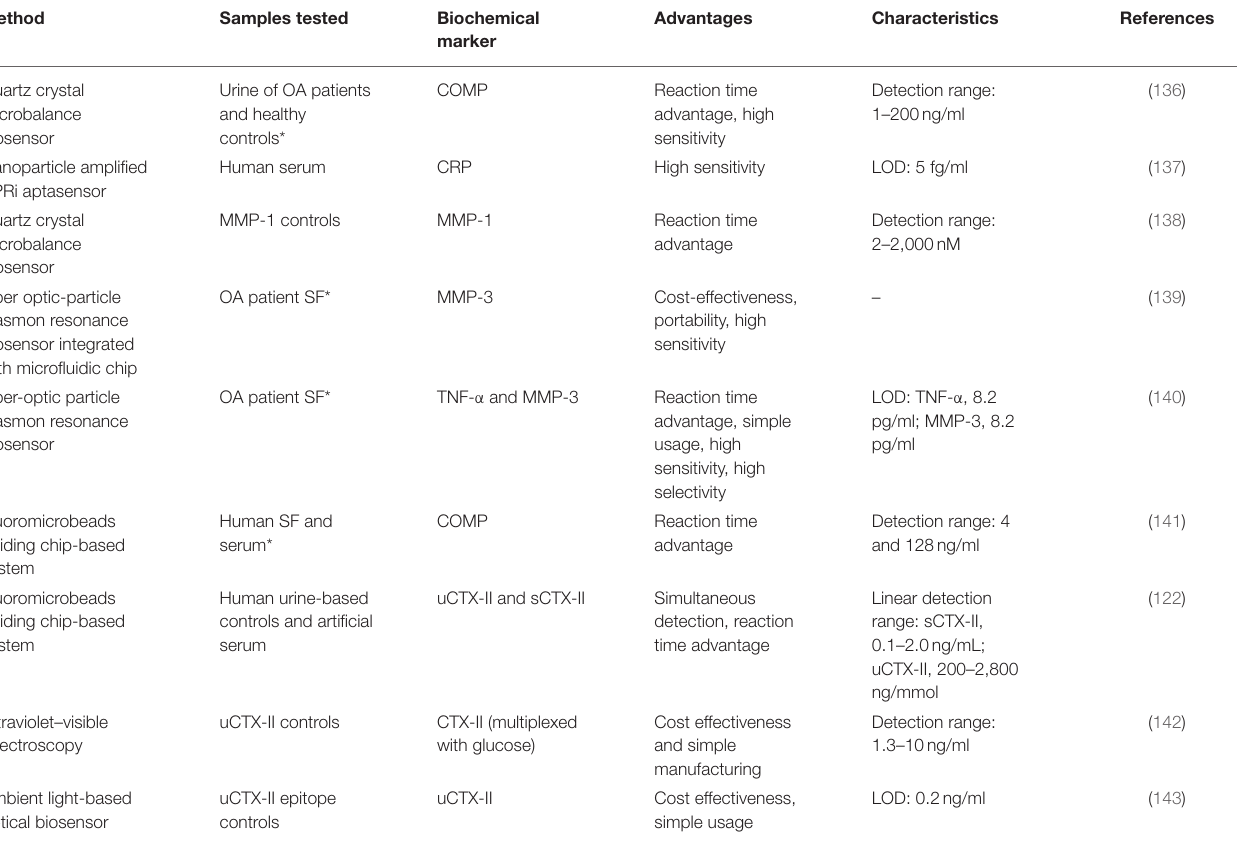
TABLE 3 | Biosensors for detection of biochemical markers relevant to OA.